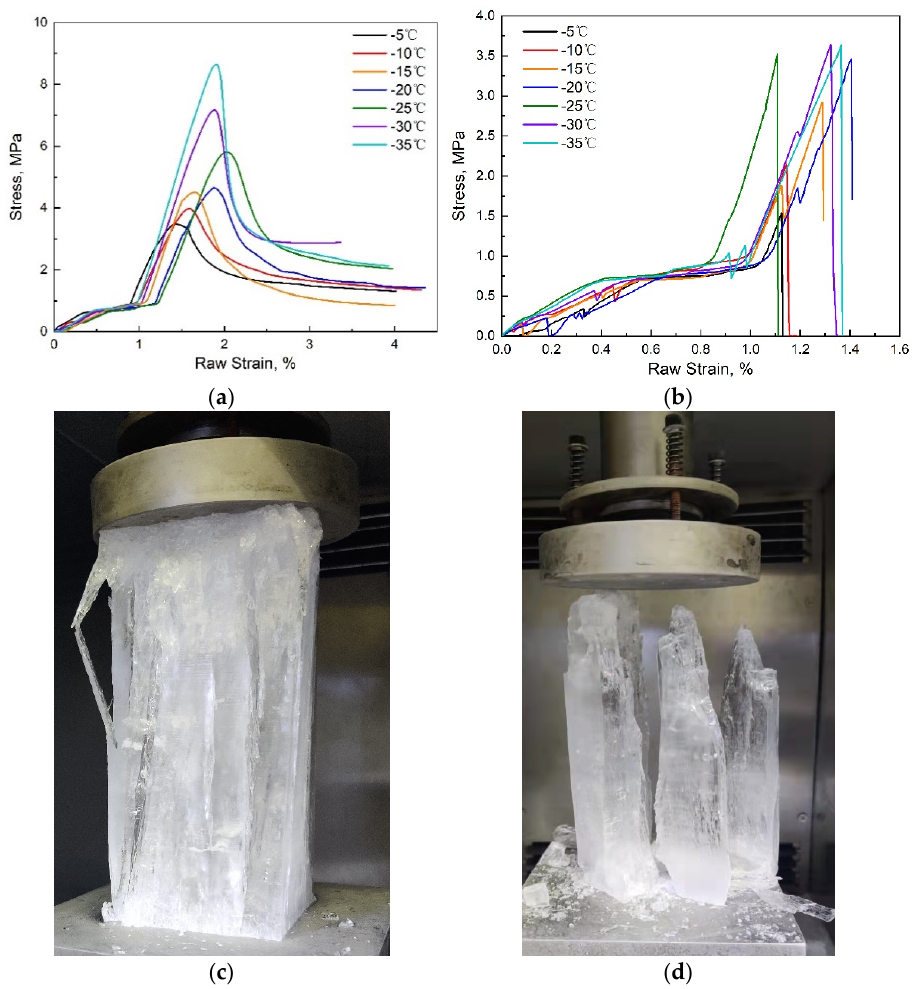
Figure 6. Stress-strain curves and deformation types of uniaxial compression on distilled water ice grown at different temperatures. ( a ) The strain rate is 10 − 5 s − 1 , at which ice samples perform ductile deformation. ( b ) The strain rate is 10 − 3 s − 1 , at which ice samples perform brittle deformation. ( c ) and ( d ) are ductile and brittle deformation respectively.